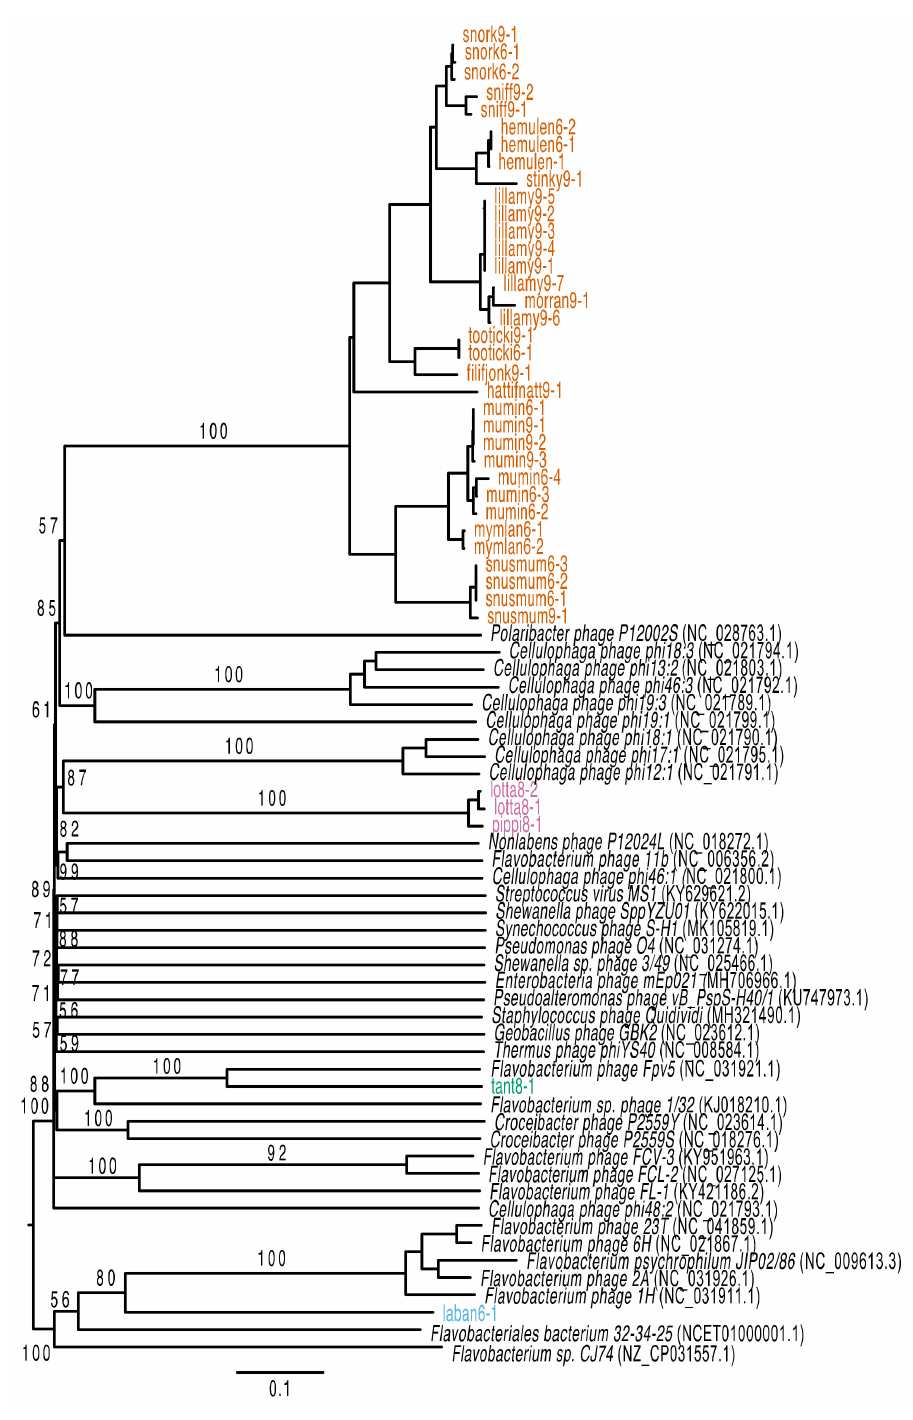
Figure 3. VICTOR tree produced with FastME based on nucleotide identity calculated with the D0-formula [73], with the newly isolated phages and reference genomes that share gene similarity to the novel phages presented in this study (accession number in parenthesis). The phages from this study are coloured based on the genera, as described in Figure 2. Bootstrap values above 50 are shown. Genes belonging to the phage in Tantvirus did not share any similarities with either Mumin- or Pippivirus genes and Muminvirus and Pippivirus shared only four genes with low (27–29%) amino acid similarity (e-value less than 0.001; Supplementary TableS S4 and S5). Thus, the pan-genomes (based on more than 70% amino acid similarity) were calculated within each genus. The